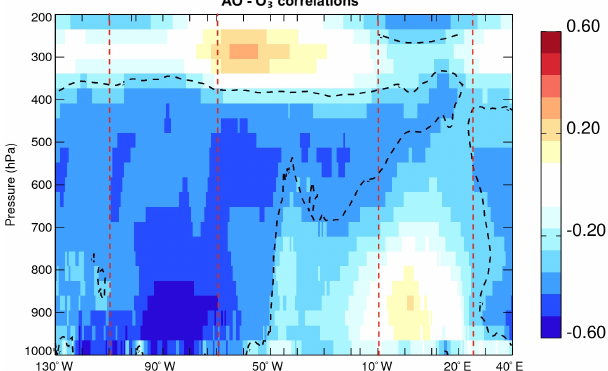
Figure 9. Longitudinal variations in correlation profiles ( r ) between AO index and simulated ozone averaged over 30 and 80 ◦ N in DJF from 1000 to 200hPa. Correlations inside black dashed lines are sta- tistically significant (d f = 25; p < 0 . 05). Red dashed lines indicate the longitudinal range for the North American region (120–60 ◦ W) and the European region (10 ◦ W–26 ◦